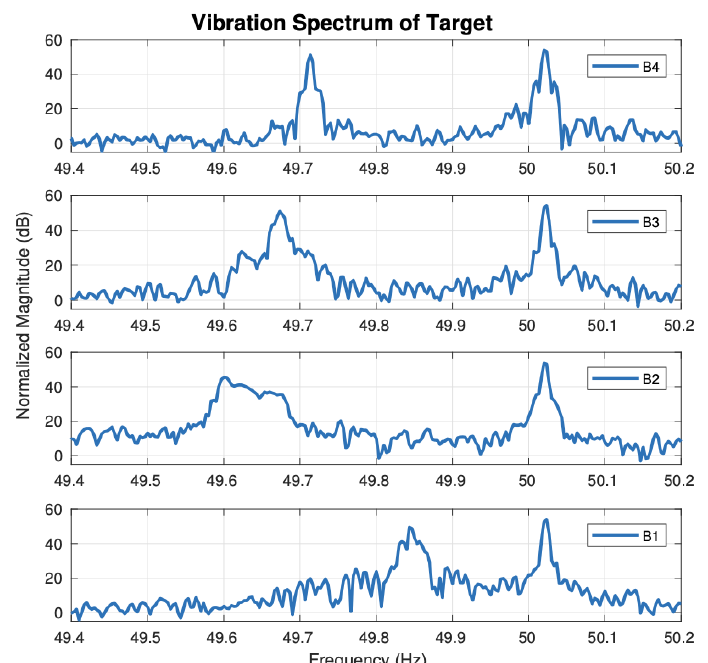
Figure 7. Vibration spectrum showing difference in multiple harmonics for each scattering matrix element